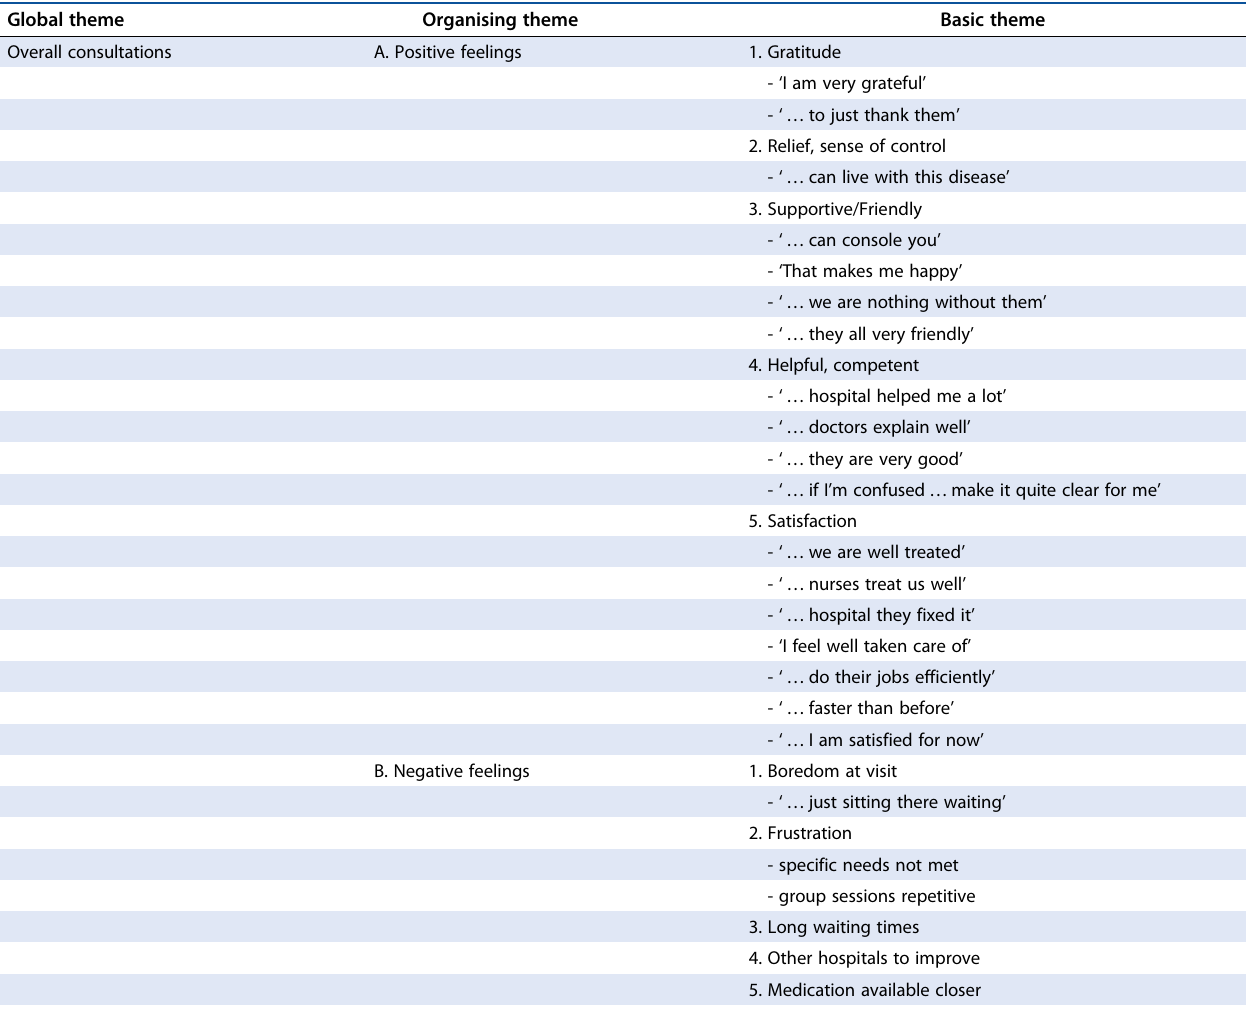
Table 4: Caregiver feelings of care consultations with the MDT Global